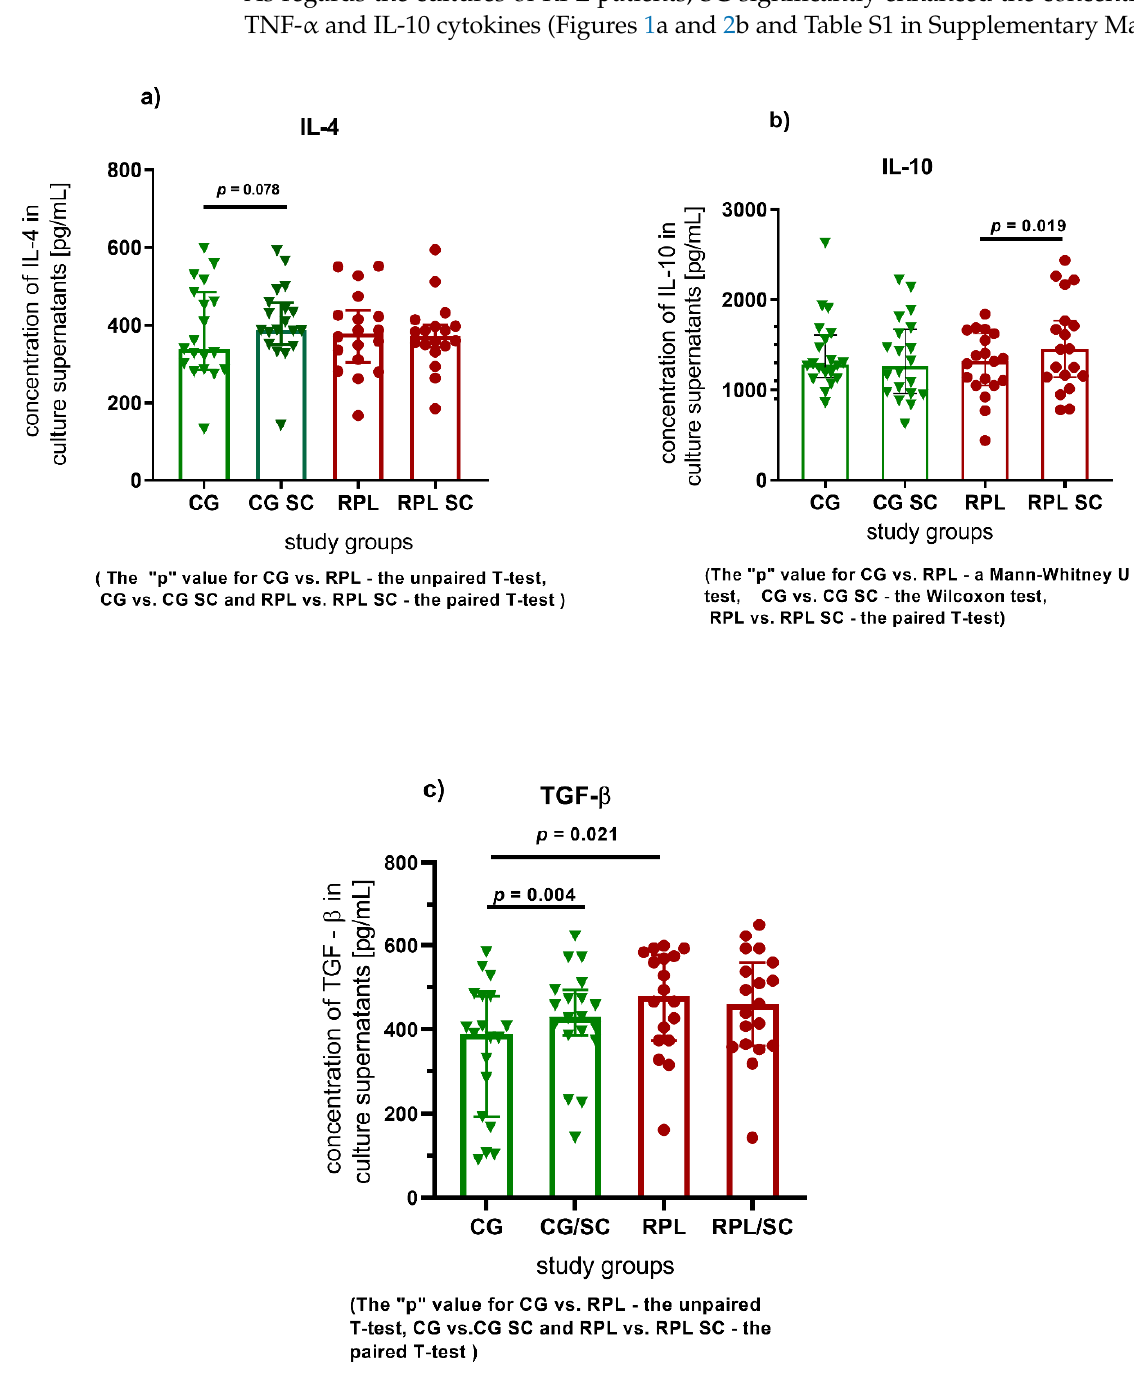
Figure 2. The comparison of anti-inflammatory cytokine concentrations in fertile and RPL women PBMC cultures, and the influence of SC on cytokine concentrations, ( a ) IL-4 concentration in culture supernatants, ( b ) IL-10 concentration in culture supernatants, ( c ) TGF – β concentration in culture supernatants, (CG—control group, green symbols, n = 20; RPL—study group, red dots; n = 21; SC—sildenafil citrate; data shown as individual values, the median and IQR). The statistical tests used to establish significant differences are given in the below graphs.